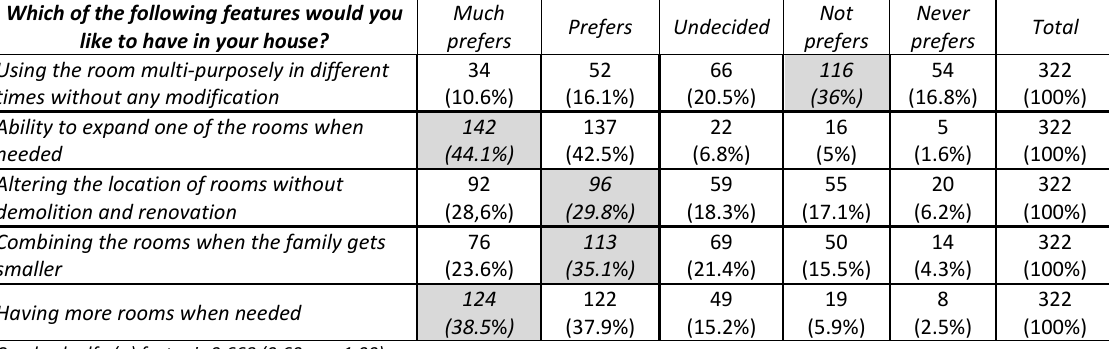
Table 3 Preferred housing flexibility options towards